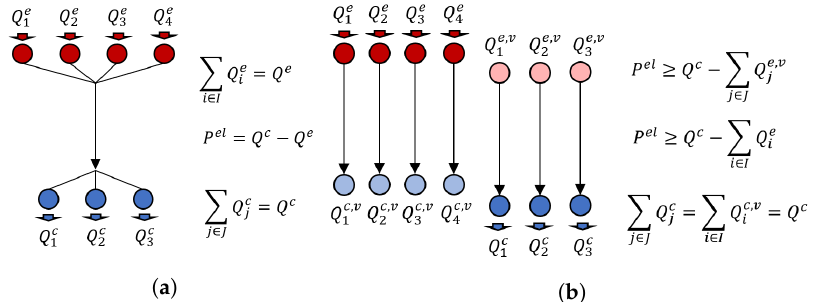
Figure 9. Schematic representation of ( a ) nonlinear and ( b ) new linear HP model, including basic